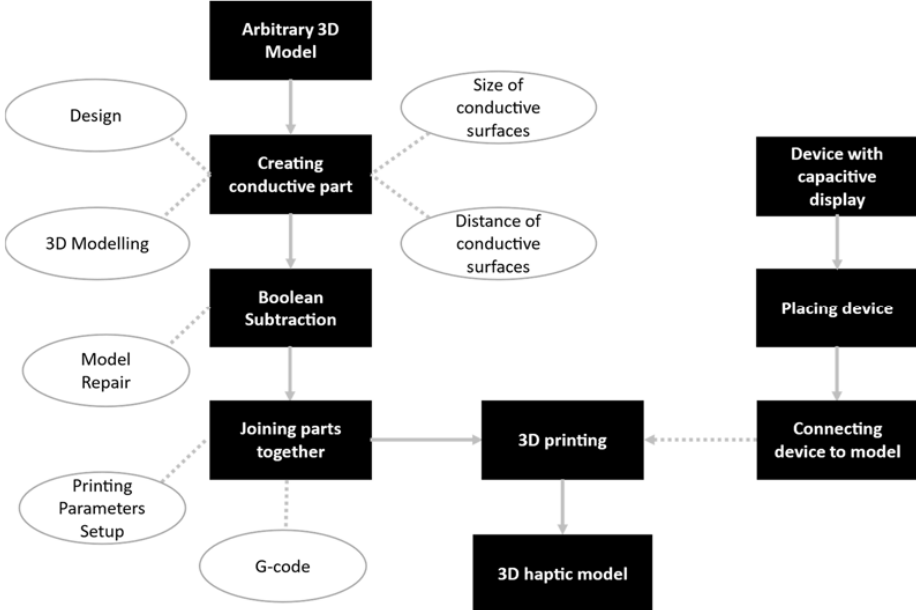
Figure 4. Workflow for creating a haptic 3D model. Any 3D model can be processed with the presented steps, implementing the TouchIt3D technology.